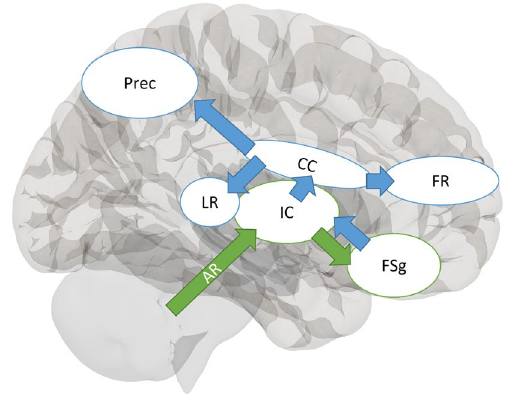
Figure 3. Diagram of proposed mechanism for tinnitus persistence. In this model, sensory signals from auditory radiations are propagated to the internal capsule, from where they are projected to the ventromedial prefrontal cortex and nucleus accumbens. There, frontostriatal gating as described by Rauschecker et al. 15 takes place. Following evaluation of the tinnitus signal, frontal regions propagate signal back to the internal capsule, and the perception of a negative stimulus has a wider impact on limbic and frontal regions. Green arrows represent signal propogation prior to frontostriatal gating, while blue arrows represent the signal following frontostriatal gating. AR: acoustic radiations, IC: internal capsule, FSg: frontostriatal gating (consisting of the ventromedial prefrontal cortex and nucleus accumbens), CC: corpus callosum, FR: frontal regions, LR: limbic regions, Prec: